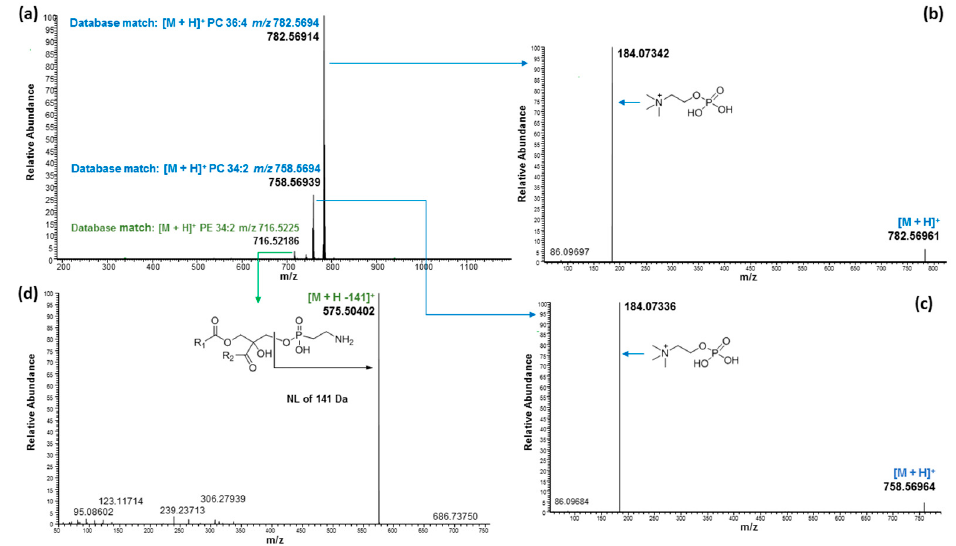
Figure 6. Mass spectra of PCs and PE eluted around 6.60 min with molecular ion at m / z 782.56914, 758.56939 and 716.52186 in positive mode ( a ), fragmentation of PC with molecular ion m / z 782.76914 ( b ), fragmentation of PC with molecular ion m / z 758.56939 ( c ), and fragmentation of PE with molecular ion m / z 716.52186 ( d ).